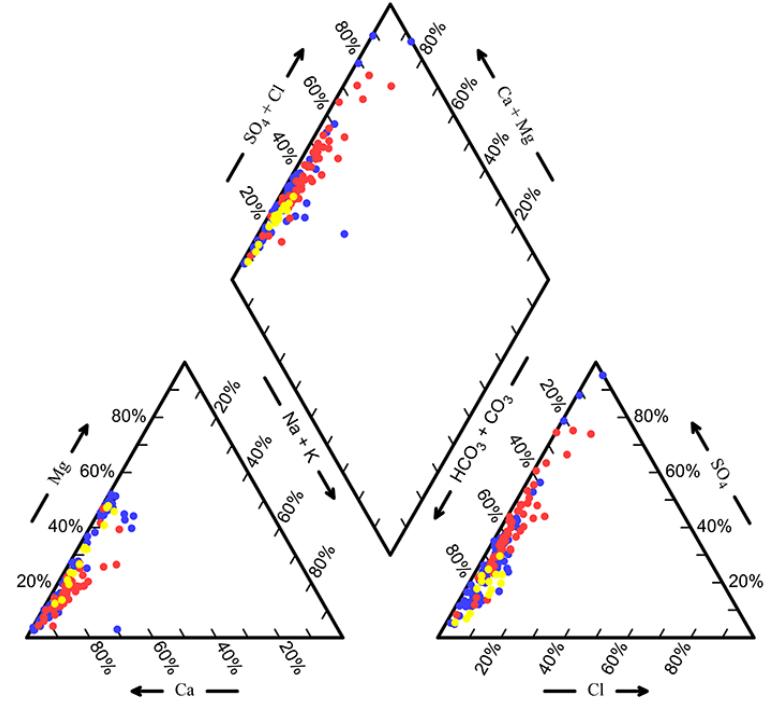
Figure 2. Piper diagram of groundwater samples in the study area.